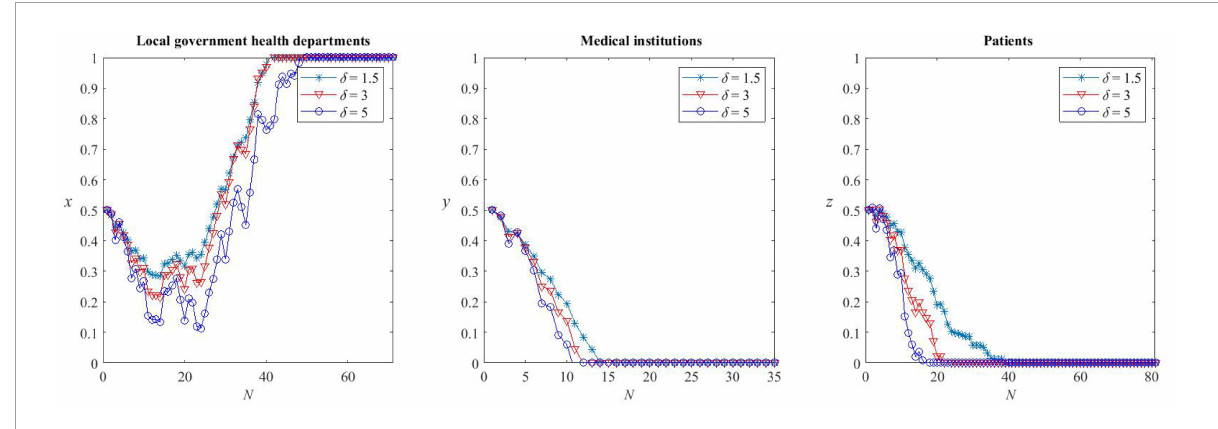
FIGURE11 Stochastic evolution of strategies under different medical